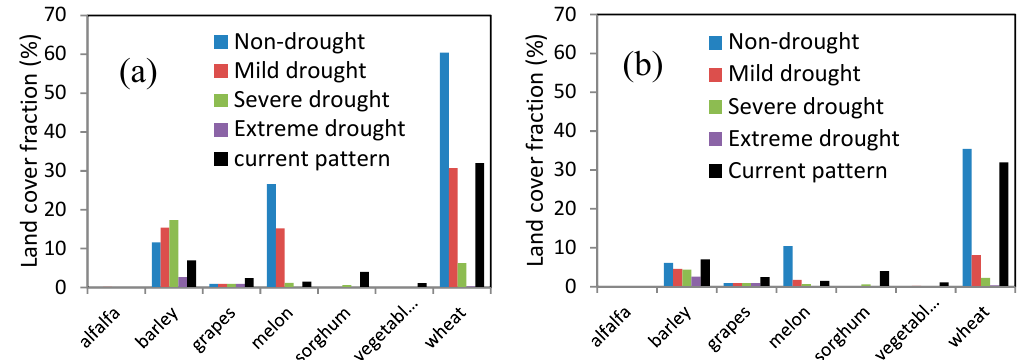
Figure 8. Comparison of cropping pattern for years with different hydrological condition Long-term profit scenario ( a ) multi-objective scenario ( b ).